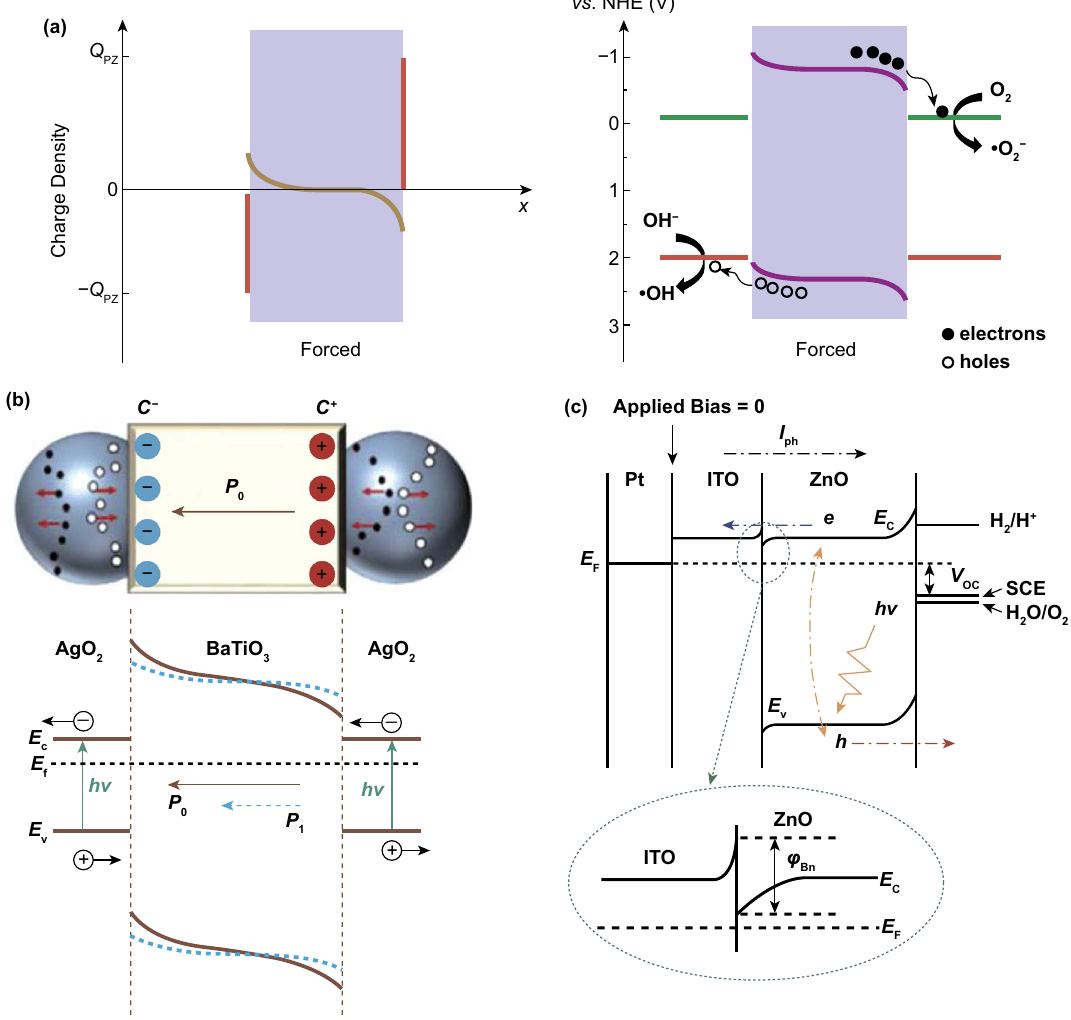
Fig. 3 a Schematic of the piezo‑catalytic effect in BTO–PDMS. Reproduced with permission [37]. Copyright 2019, American Chemical Soci‑ ety. b Schematic of charge carrier separation and transfer in Ag 2 O nanoparticles attached to two opposite surfaces of a BTO nanocube. Repro‑ duced with permission [36]. Copyright 2015, American Chemical Society. c Schematic illustration of the band lineup of the entire PEC system. Reproduced with permission [116]. Copyright 2011, American Chemical